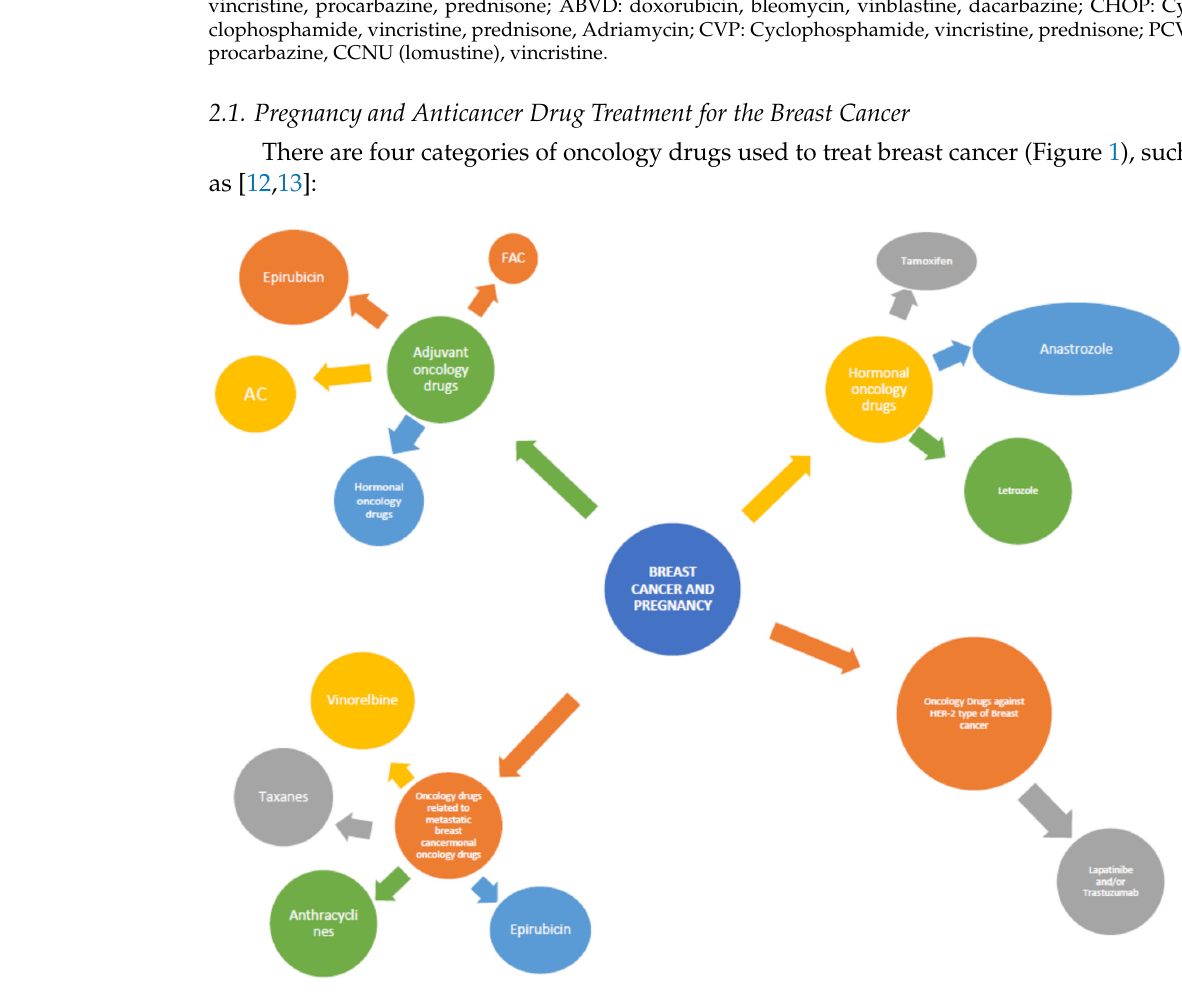
Figure 1. Breast cancer and pregnancy FAC: Fluoroucacil, Adriamycin, Cytoxan; AC: Doxorubicin, Cyclophosphamide.